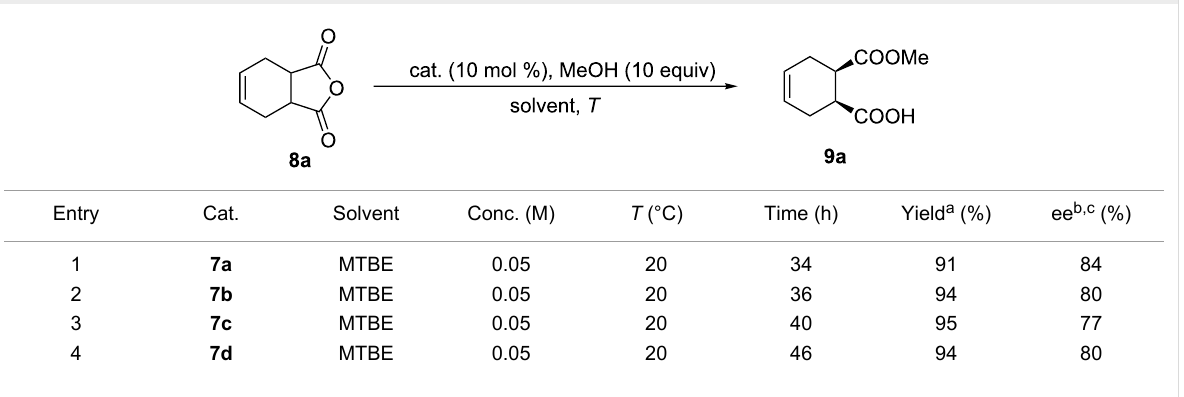
Entry Cat. Solvent Conc.